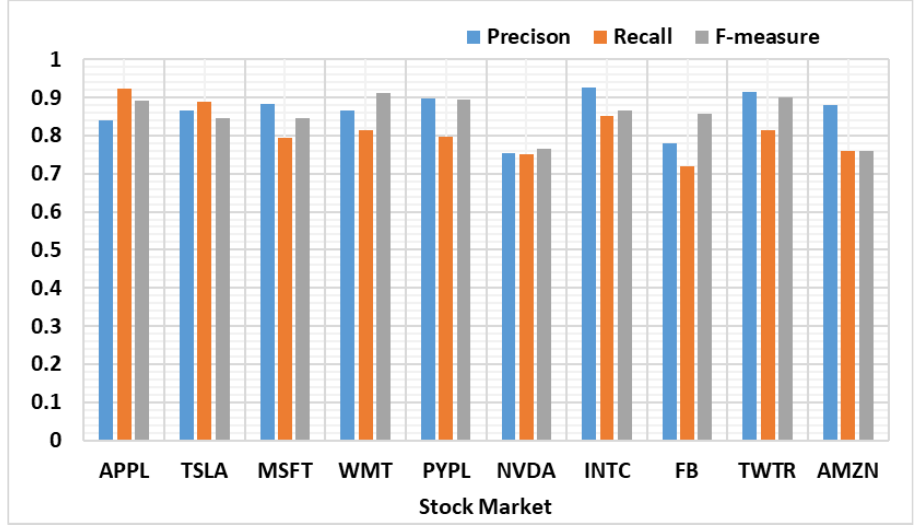
Figure 3. Brand wise